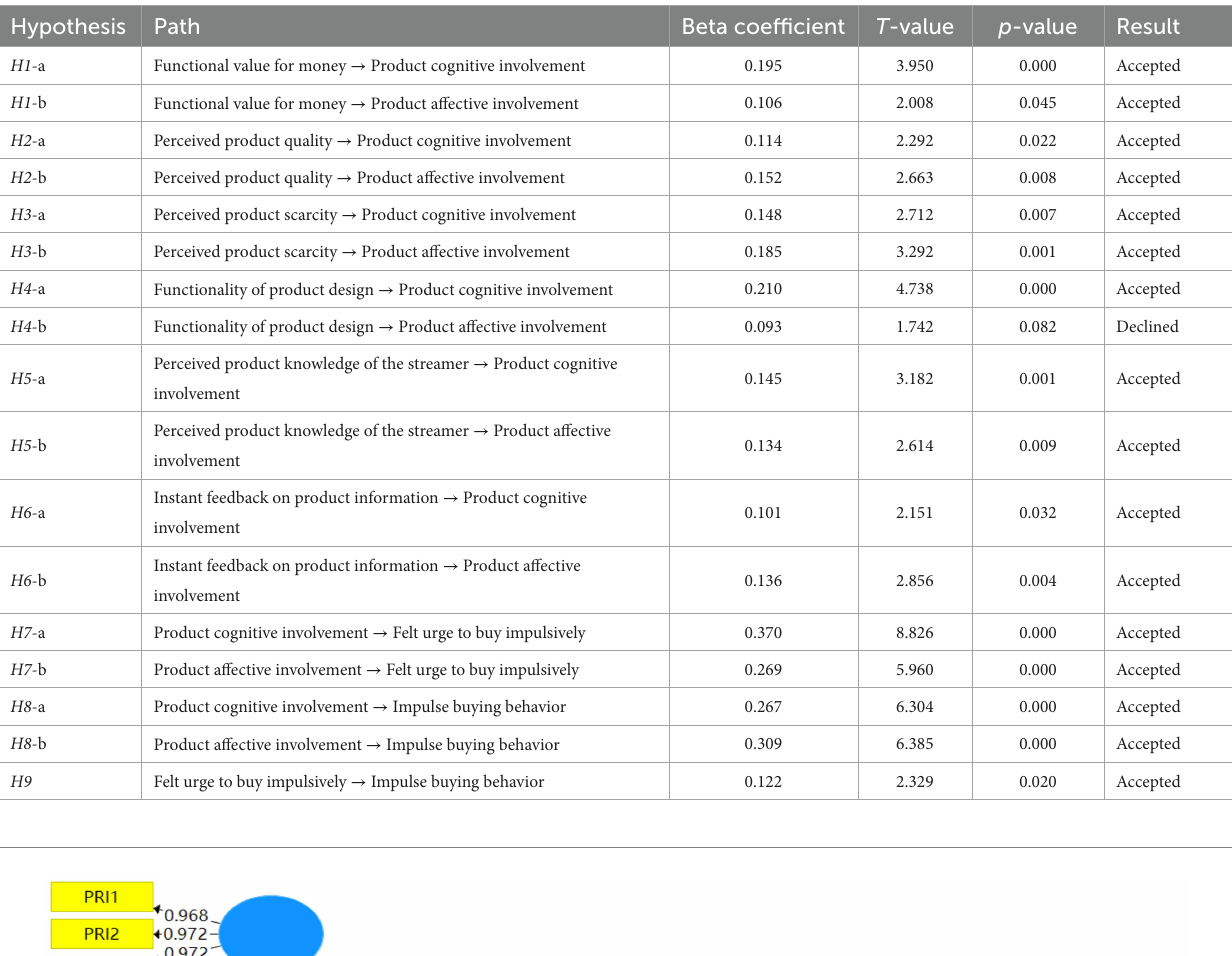
TABLE 7 Hypothesis testing ( N = 504).